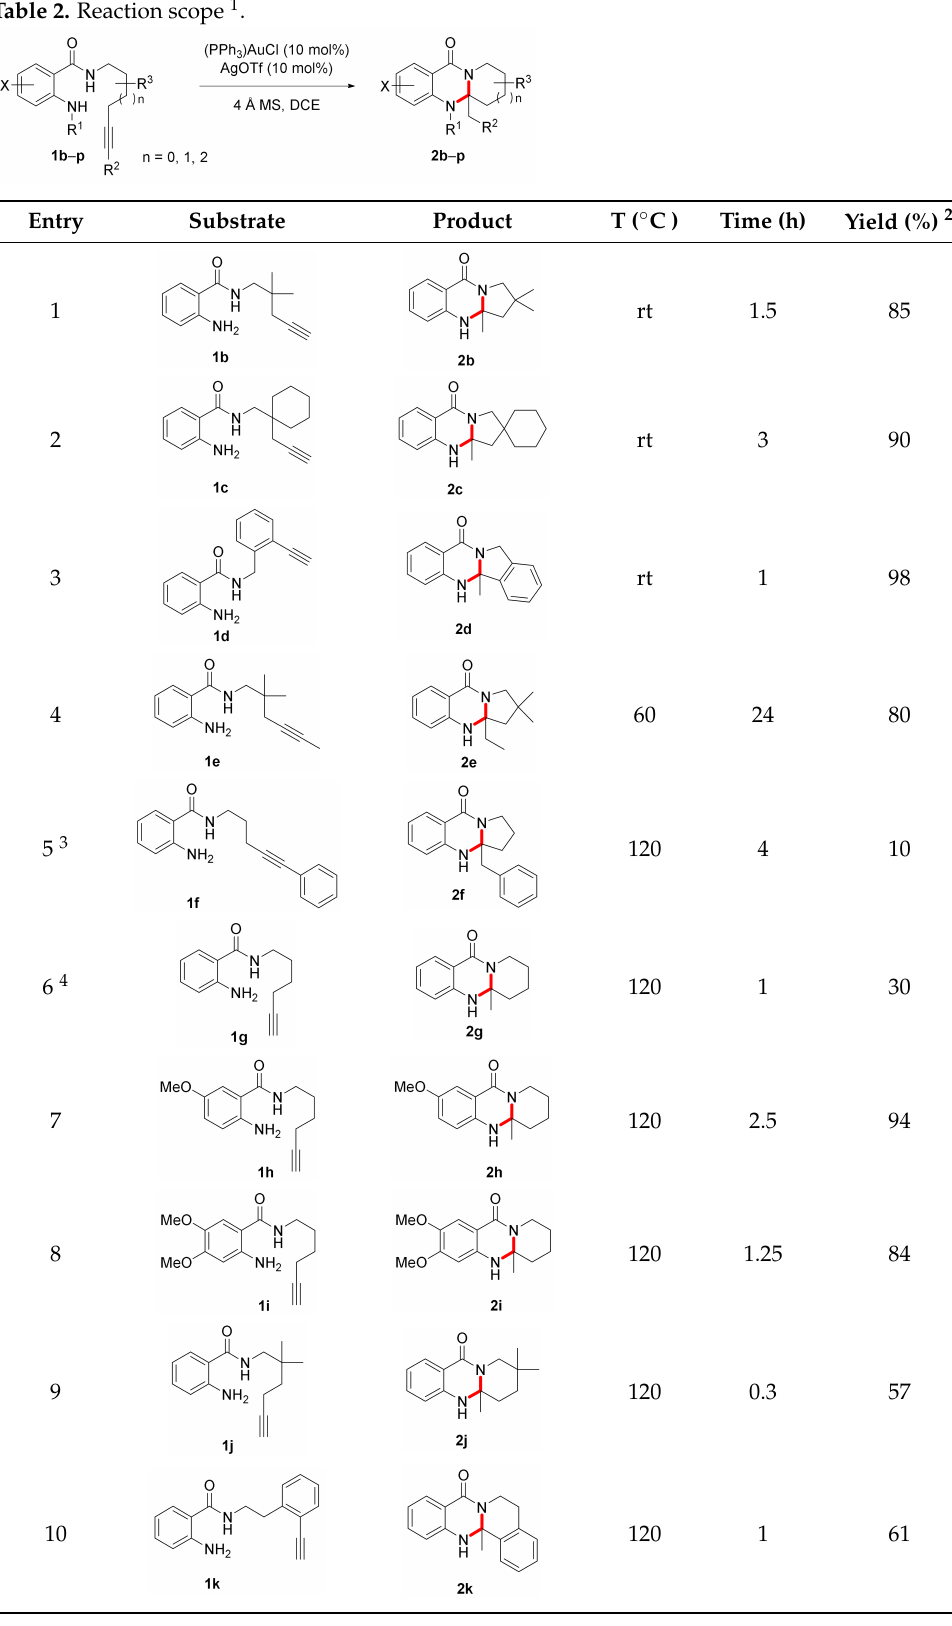
Table 2. Reaction scope 1